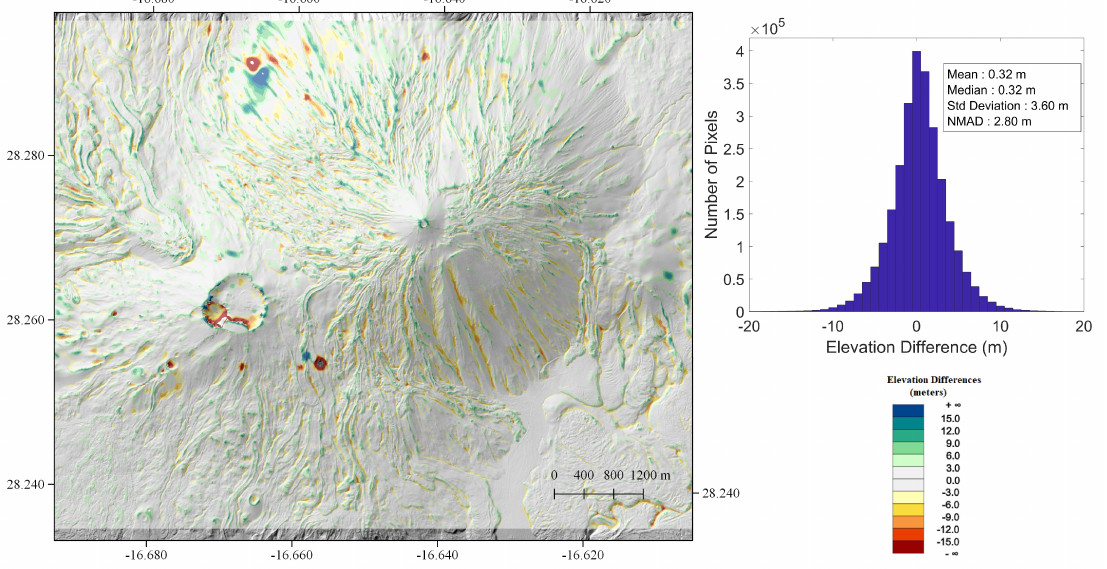
Figure 9. Elevation Differences over Mount Teide computed from the difference of the LiDAR based DTM and the ALOS DEM.